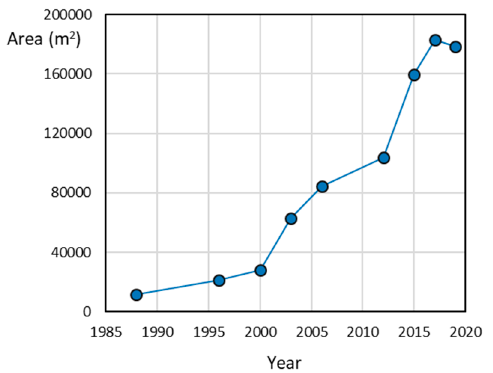
Figure 4. Historical reconstruction of the sand deposit from 1988 to 2019: border lines of the progressive growth.